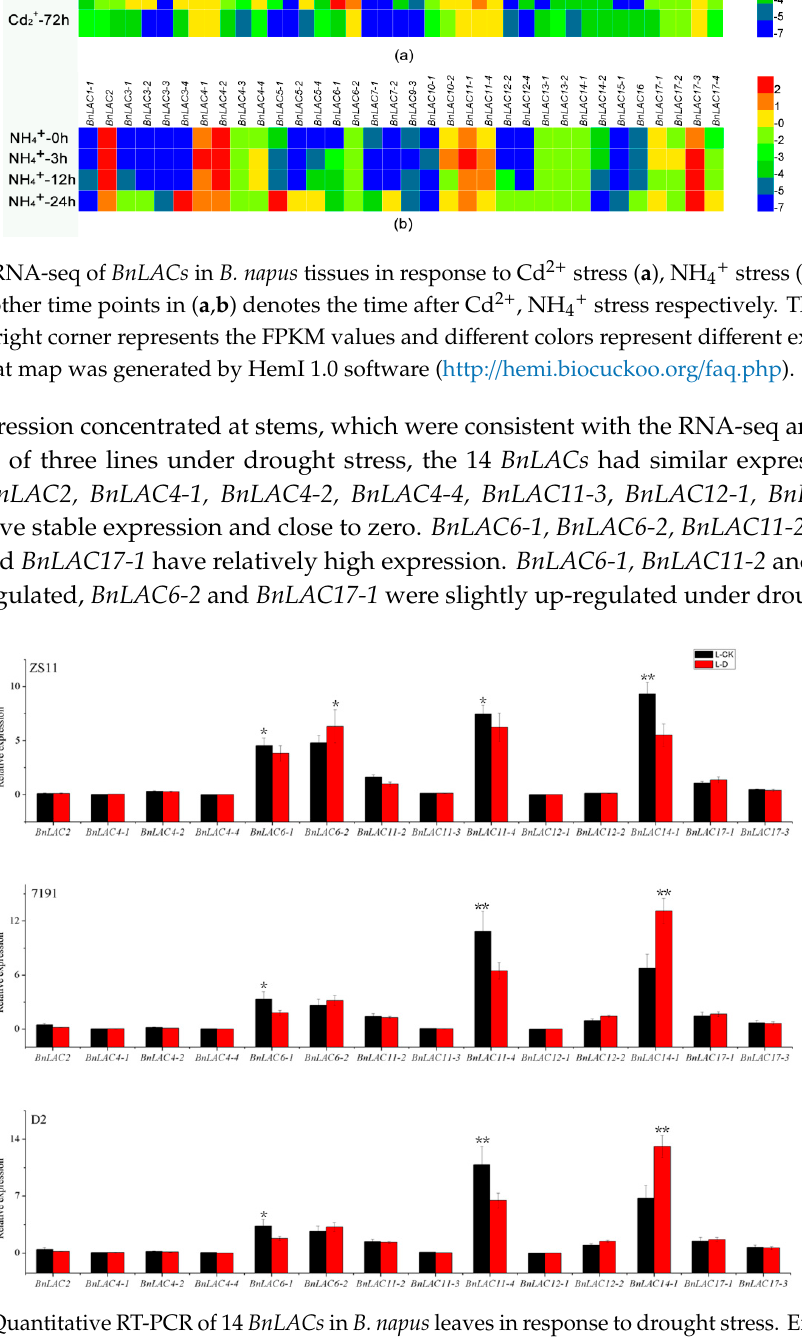
Figure 9. Quantitative RT-PCR of 14 BnLACs in B. napus leaves in response to drought stress. Expression of Actin and UBC21 were used to normalize the expression level of each LAC gene. Bars represent means ± SEM of three biological replicates. Bars marked with asterisks indicate significant di ff erences (Student’s t-test) to corresponding control samples for the same time point, * P < 0.05, ** P < 0.01. The results were presented by OriginPro 8 (OriginLab Corporation, Northampton, MA, USA). L-CK and L-D means no drought treated and drought treated,